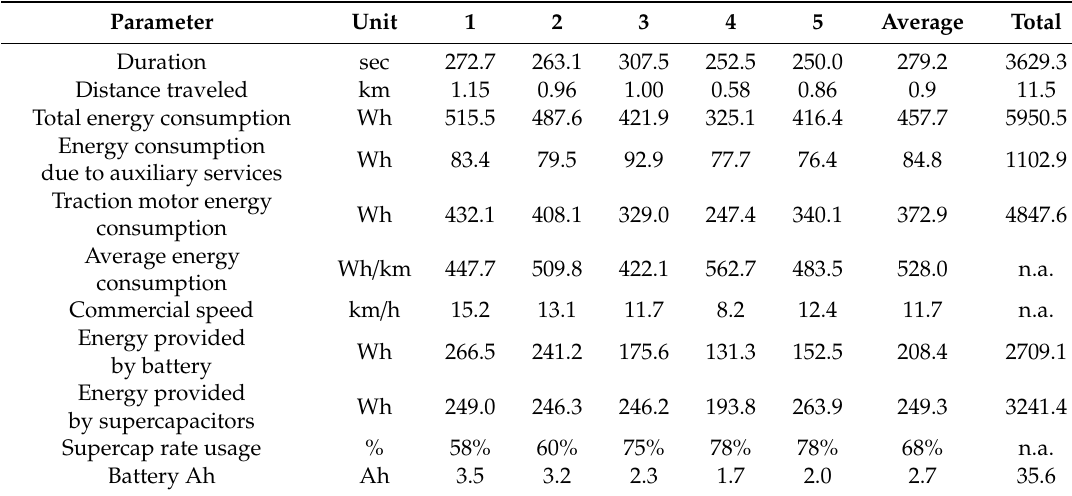
Table 3. Main test results of hybrid storage prototype (P3).